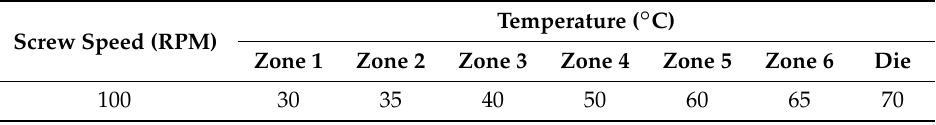
Table 1. Extrusion conditions used to compound SSB ® 55 Pharma grade Shellac.